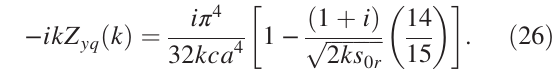
FIG. 8. Quad bunch wake for a Gaussian beam on axis, with σ ¼ 10 μ m, in the RadiaBeam/LCLS dechirper. Given are the z numerical results of ECHO(2D) (blue), and the analytical zeroth order (red) and 1st order results (green). The bunch shape λ ð s Þ with the head to the left is shown in